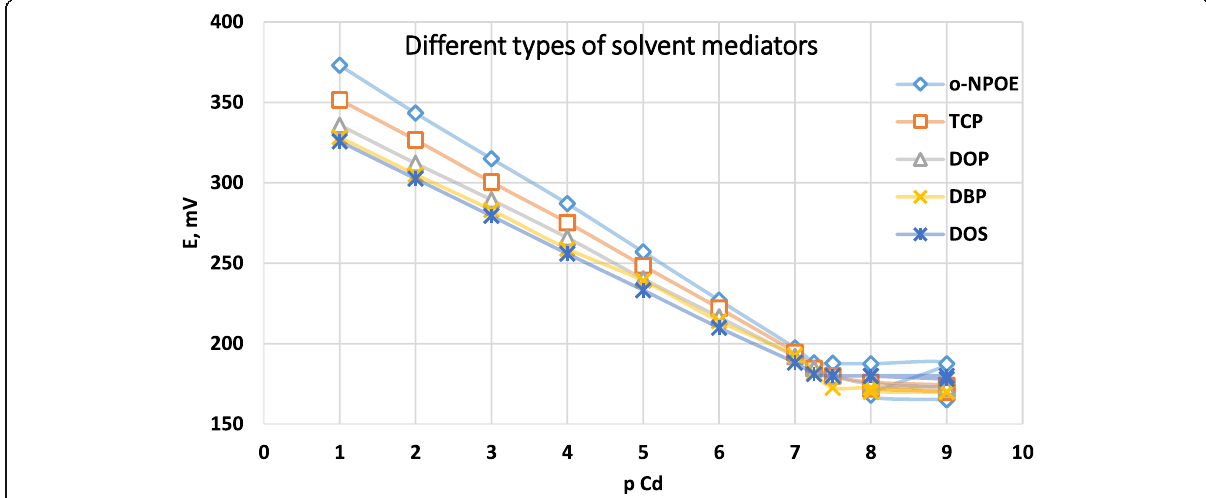
Fig. 2 Calibration of Cd(II)-CPE sensor corresponding to the type of solvent mediator